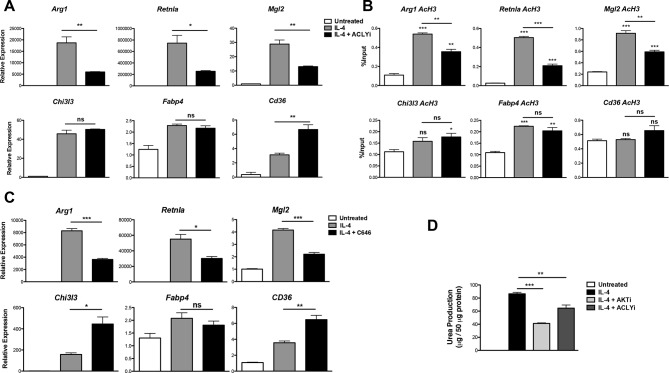
Acly controls inducible histone acetylation at some M2 genes. (A) Acly regulates induction of some M2 genes. BMDMs stimulated for 16 hr with IL-4 +/- Acly inhibitor pretreatment were analyzed for M2 gene induction by qRT-PCR. (B) Acly regulates inducible H3 acetylation at some M2 genes. BMDMs stimulated for 16 hr with IL-4 +/- Acly inhibitor pretreatment were subject to ChIP analysis using antibodies to acetylated H3. Enrichment of the indicated M2 gene promoters was assessed by qRT-PCR. (C) The p300 inhibitor C646 reduces induction of some M2 genes. BMDMs stimulated for 16 hr with IL-4 +/- C646 pretreatment were analyzed for M2 gene induction by qRT-PCR. (D) Akt and Acly control IL-4-inducible arginase activity. BMDMs were stimulated for IL-4 for 24 hr +/- inhibitor pretreatment, followed by analysis of arginase activity in cellular lysates as assessed by urea production. The student’s t-test was used to determine statistical significance, defined as *P<0.05, **P<0.01, and ***P<0.001.